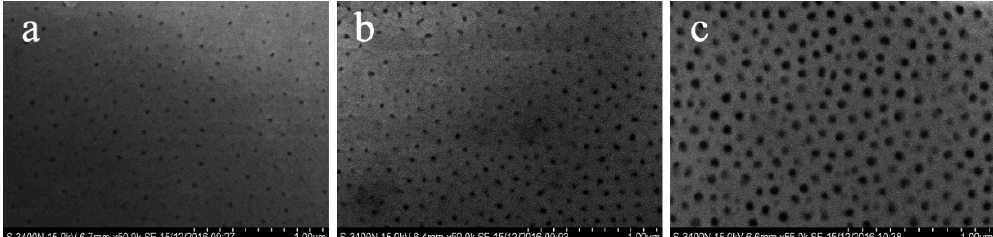
Figure 1. SEM images of micro-morphology on the nanoporous hydrophilic aluminum surfaces: ( a ) Sample 2, d = 150 nm; ( b ) Sample 3, d = 350 nm; and ( c ) Sample 4, d = 700 nm.